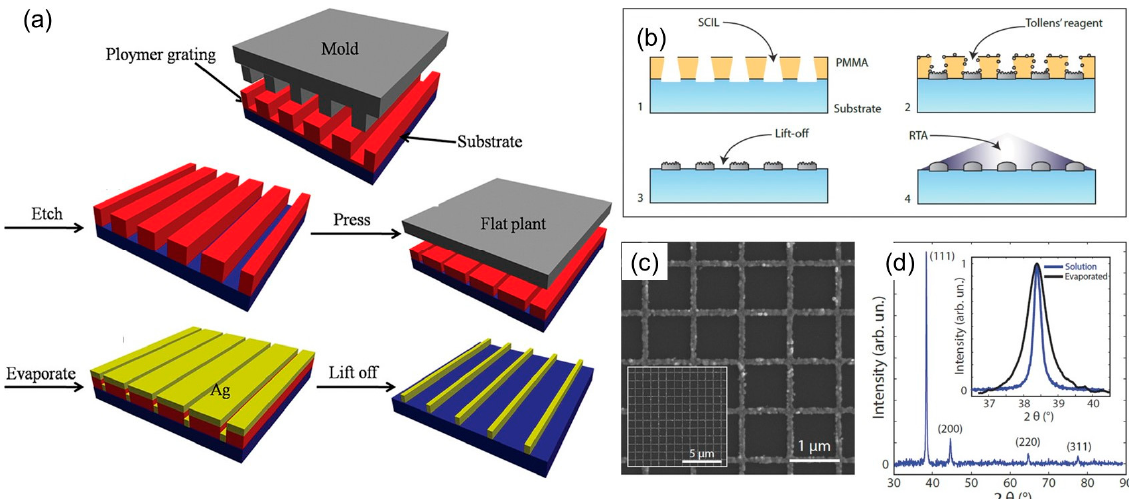
Figure 5. ( a ) Schematic illustration of the fabrication process of the metal nanowires. Reproduced with permission from Ref. [38]. Copyright 2011, American Chemical Society. ( b – d ) ( b ) Schematic of the solution-grown nanowire network fabrication process: (1) SCIL to produce a grid nanopattern in PMMA, (2) solution phase growth of Ag nanowires in the trenches defined by the template via the Tollens’ reaction, (3) lift-off, and (4) RTA to smooth the nanowire surface. ( c ) SEM images of a freshly grown nanowire network before RTA treatment, showing the confinement of the growth over a large area. ( d ) XRD before RTA treatment of solution-grown nanowire network measured in the range 30°–90° with the θ –2 θ configuration, showing the crystalline nature of the nanowire; inset: comparison of the (111) Ag reflection peak for solution-grown and evaporated Ag, indicating the larger average grain size in the former. Reproduced with permission from Ref. [39]. Copyright 2016, Wiley.